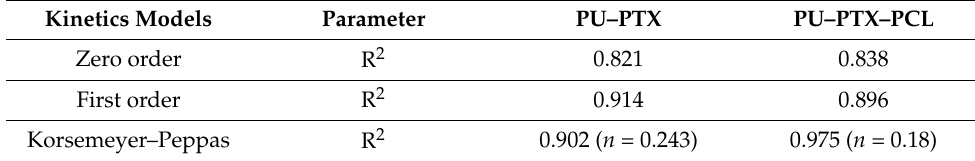
Table 1. In vitro drug release kinetics of PTX from PU-PTX and